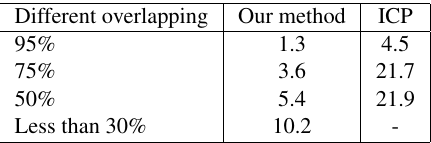
Table 2. Accuracy of different ratio of overlapping